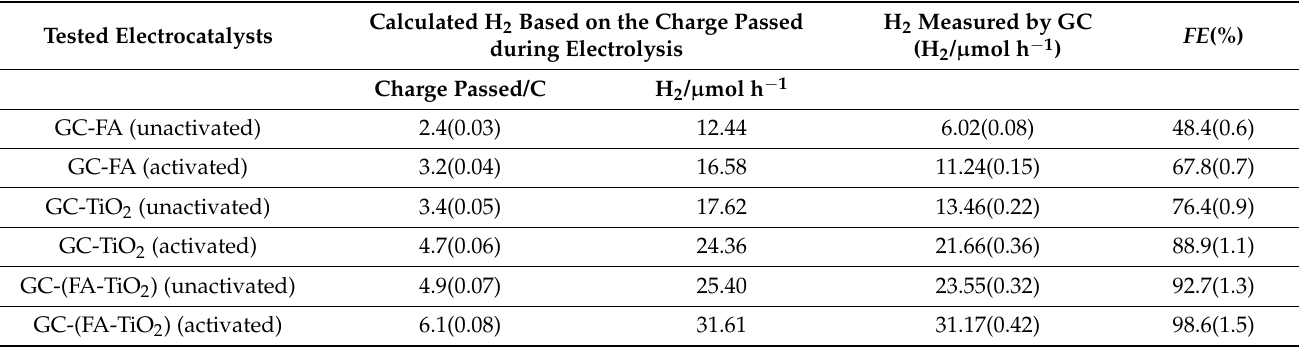
Table 4. Mean value (standard deviation) of V H2 (measured and calculated) obtained after 1 h of a controlled galvanostatic electrolysis (CGE) *, together with the Faradaic Efficiency (FE) values, ε (%), for the studied catalysts.